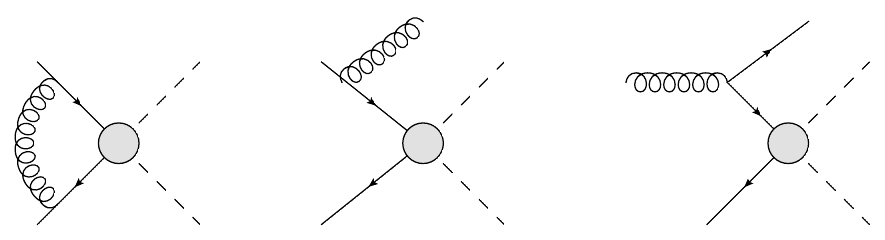
Figure 6 . Generic form of the QCD corrections of order O ( (cid:11) s ) to the qqA Higgs pair production. The parton luminosity is given